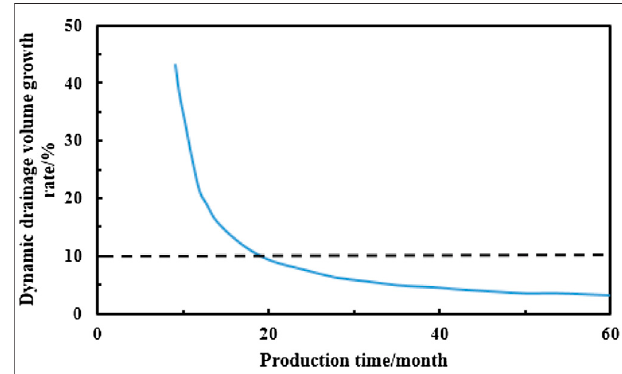
FIGURE 4 | Dynamic drainage volume growth rate.